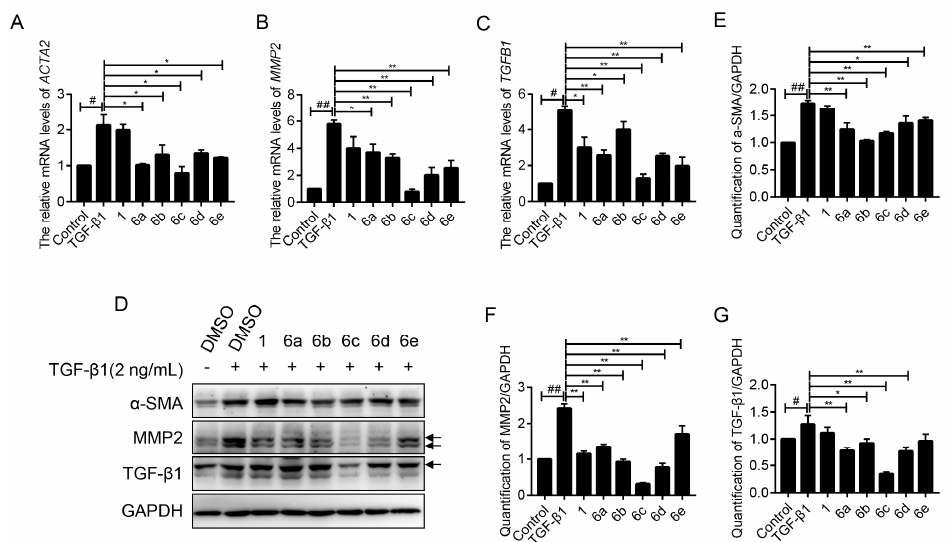
Figure 4. Inhibition effects of these compounds on fibrogenic genes. The mRNA levels of ACTA2 ( A ), MMP2 ( B ), and TGFB1 ( C ) in LX-2 cells after treatment with the indicated compounds (10 μ M), together with TGF- β 1 (2 ng/mL) for 24 h were examined by real-time PCR (RT-PCR). The mRNA level was normalized against GAPDH . Data were presented as the mean ± SEM, # p < 0.05, ## p < 0.01 as compared to that of control group; * p < 0.05, ** p < 0.01 as compared to that of TGF- β 1 group. ( D ) The protein expression levels of α -SMA, MMP2, and TGF- β 1 in LX-2 cells after treatment with the indicated compounds, together with TGF- β 1 (2 ng/mL) for 24 h were detected by western blot assay. GAPDH served as internal reference. ( E – G ) Quantification of the intensities of α -SMA ( E ), MMP2 ( F ), and TGF- β 1 ( G ) of ( D ). Data were presented as the mean ± SEM, # p < 0.05, ## p < 0.01 as compared to that of control group; * p < 0.05, ** p < 0.01 as compared to that of TGF- β 1 group.